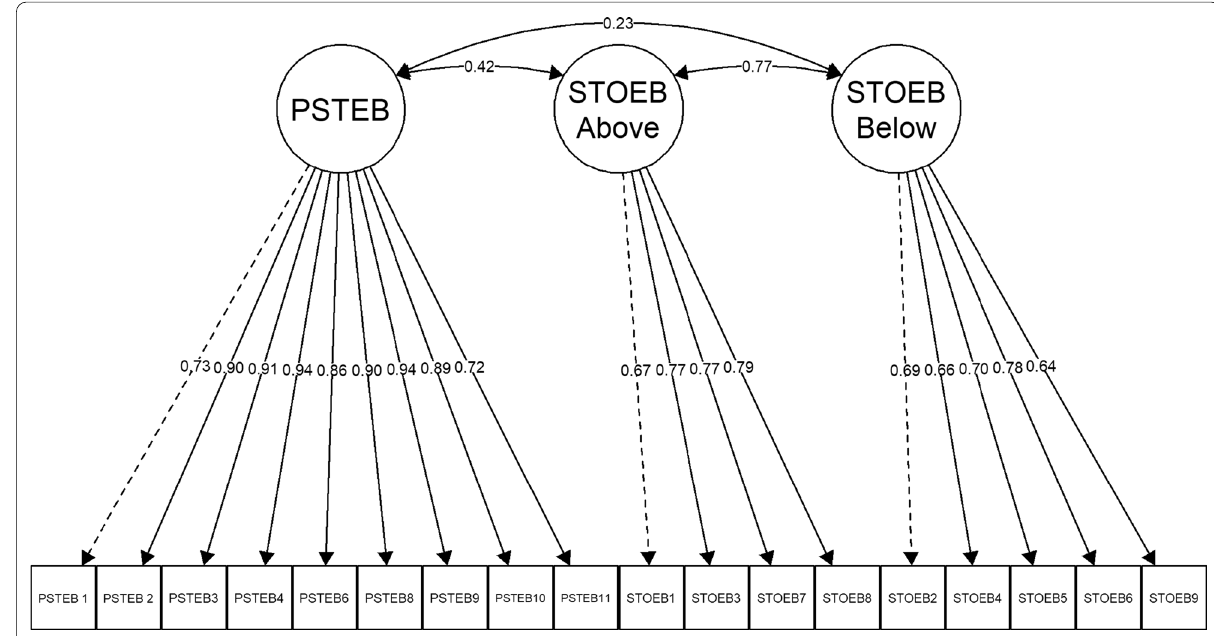
Fig. 2 CFA path diagram with standardized loadings for 3-factor